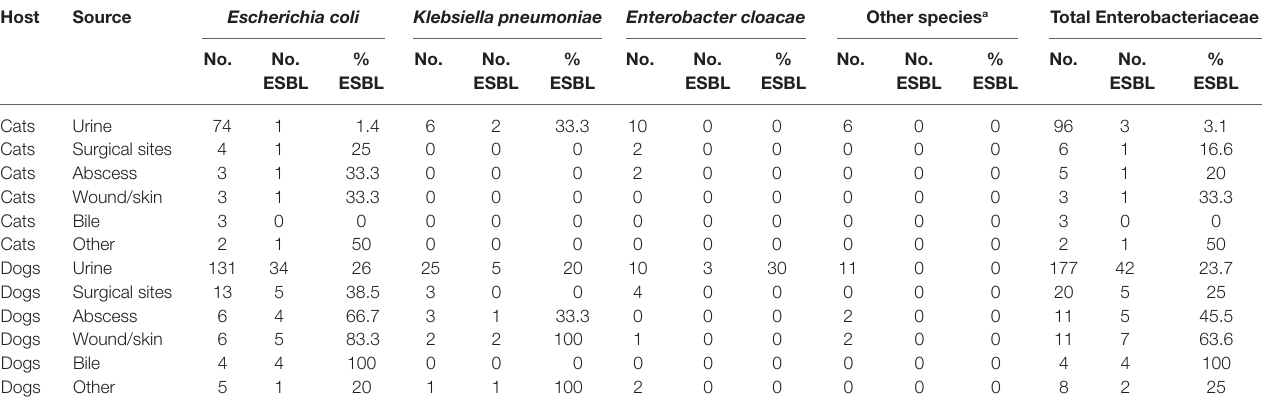
TaBle 1 | Percent and distribution of extended-spectrum β -lactamases (ESBL) producers among clinical Enterobacteriaceae from cats and dogs in Switzerland, 2012–2016. host source